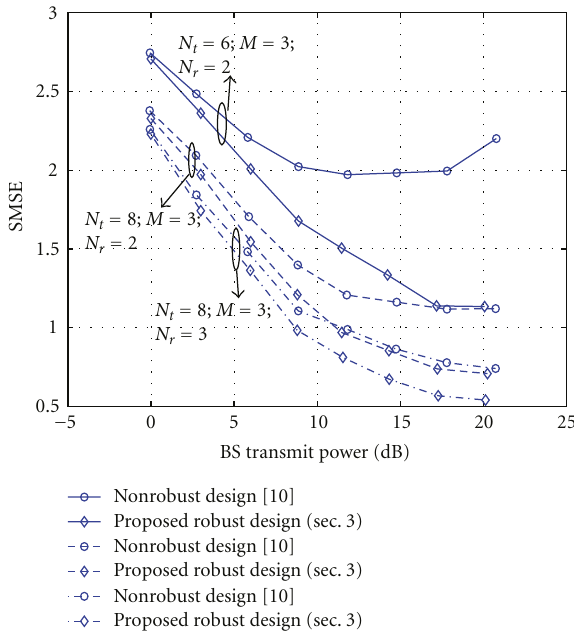
Figure 2: SMSE versus BS transmit power ( P T = (cid:3) B (cid:3) 2 F ) perfor- mance of the proposed robust design in Section 3 for the SE model. M = 3, N N N L N = L = L = 2, σ 2 = t = 8,6, r 1 = r 2 = r 3 = 2, n 1 2 3